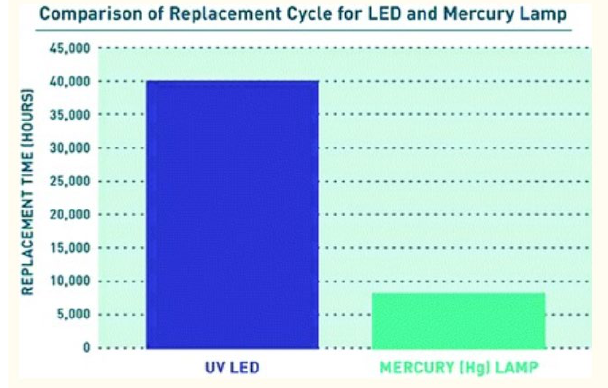
Figure 1. Comparison of UV LED and Mercury lamp